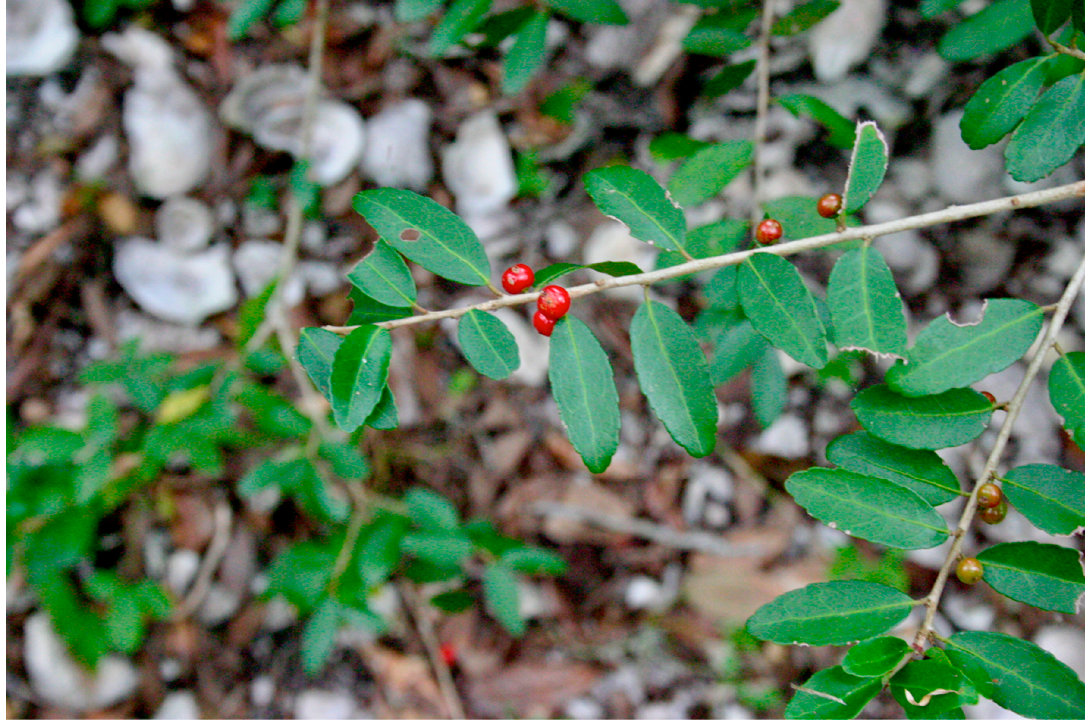
Figure 10. Yaupon plant growing on Shell Mound. Photograph courtesy of the author.